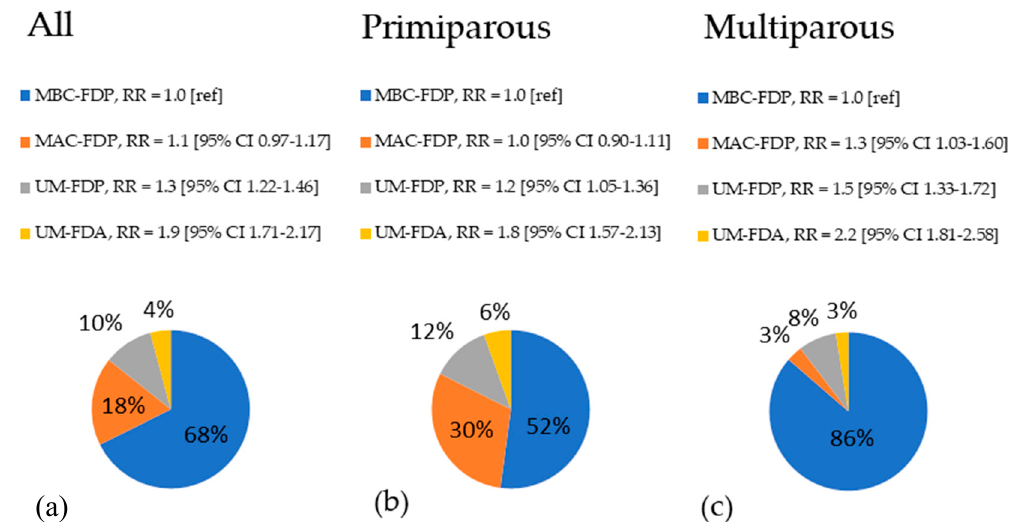
Figure 1. Pie charts of frequencies of Marital-Father Data groups in the entire group of mothers ( a ) and separately among primiparous ( b ) and multiparous ( c ) together with adjusted risk ratios of preterm birth, associated with different types of mother-father relationship (proxied by Marital-Father Data groups), calculated with reference to MBC-FDP